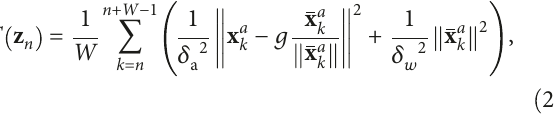
Figure 4: Judgment of zero-velocity